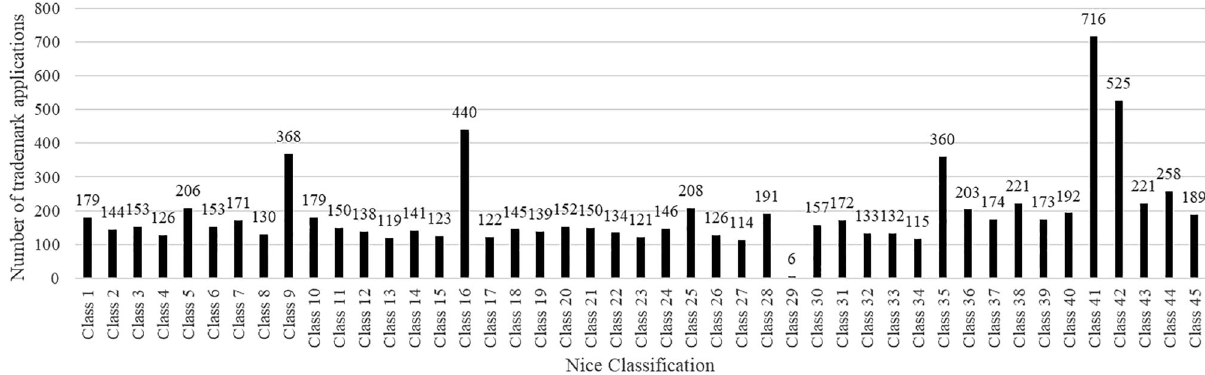
Fig. 2 Distribution of the 42 fi rst-class universities ’ trademarks in the Nice Classi fi cation. There are fewer trademarks in the fi gure than the total number because some applications are still pending acceptance and thus could not be reviewed for speci fi c